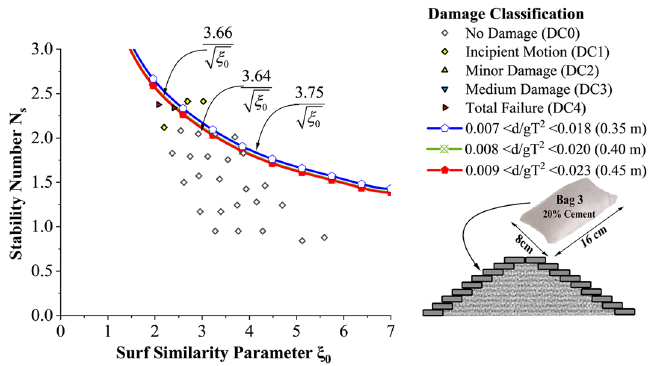
Figure 11. Incipient motion curves for Bag 3 filled with 20% cement, arranged to a single layer.